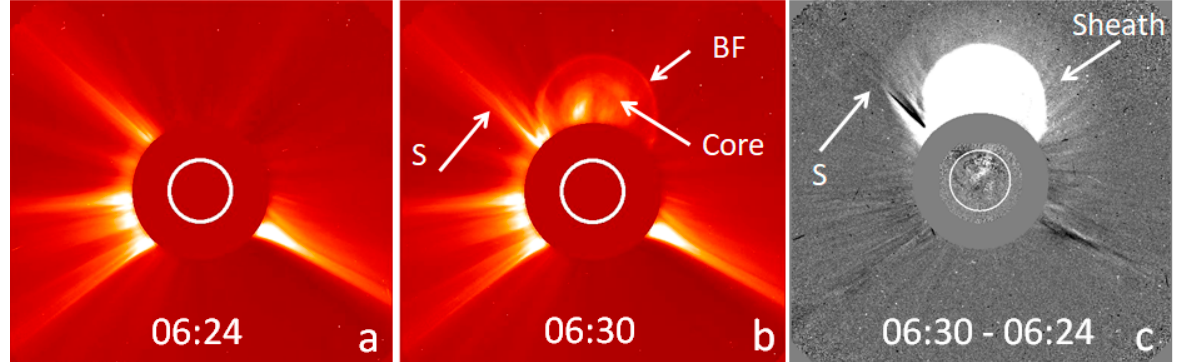
Figure 1. SOHO/LASCO/C2 images of the 15 January 2005 CME showing the basic morphology. The 06:24 UT image ( a ) shows the pre-eruption corona featuring several streamers. The white circle on the image of the coronagraph occulting disk denotes the optical Sun. Six minutes later, a CME appears in the north–northwest part of the corona with a bright front (BF) and bright core ( b ). The void can be seen separating BF and the core. “S” denotes a kink that appears outside of the BF. The difference between the frames ( a ) and ( b ) shows the coronal changes occurring over a period of 6 min ( c ). The kink S is at the outer boundary of the diffuse structure that envelopes BF. An EUV difference image, superposed on the LASCO difference image, shows disturbances on the solar disk indicating the eruption (adapted from [17]).